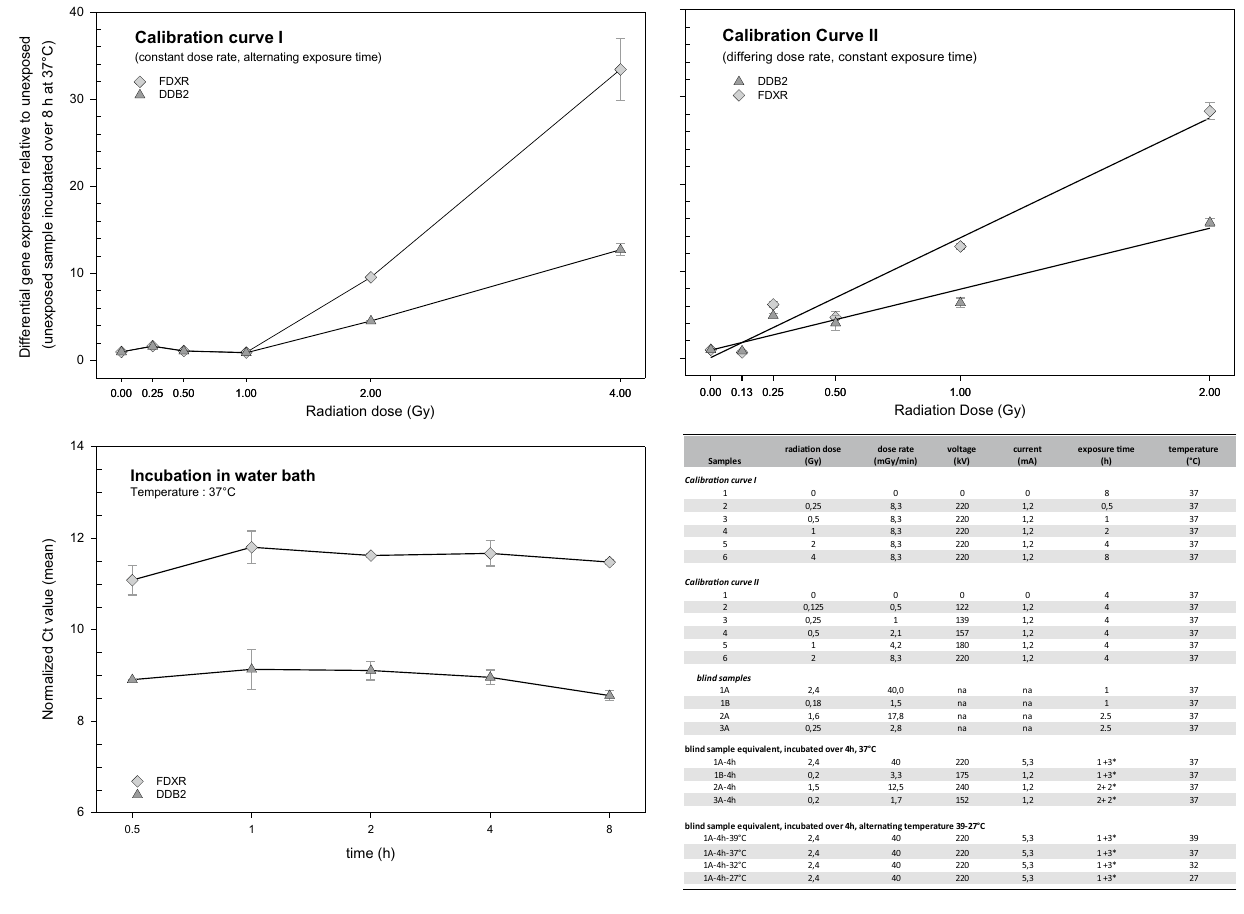
Figure 1. Typical calibration curves I ( A ) and II ( B ) were generated using two radiation-induced genes ( FDXR and DDB2 ) and exposures as shown in the Table to the bottom right. Unexposed samples incubated over 8 h at 37 °C showed constant gene expression values over time ( C ) indicating that the reference of 0 Gy incubated over 8 h will not introduce a bias in samples irradiated over a shorter period of time as shown in the Table for calibration curve I. Symbols represent mean gene expression values from technical replicates. Error bars represent standard deviation of duplicate measurements and are visible when larger than the symbols. Calibration curves were generated before the exercise (n = 6) and those shown herein represent typical examples (graph created using SigmaPlot Version 14.0, http:// www. systa tsoft ware. com).